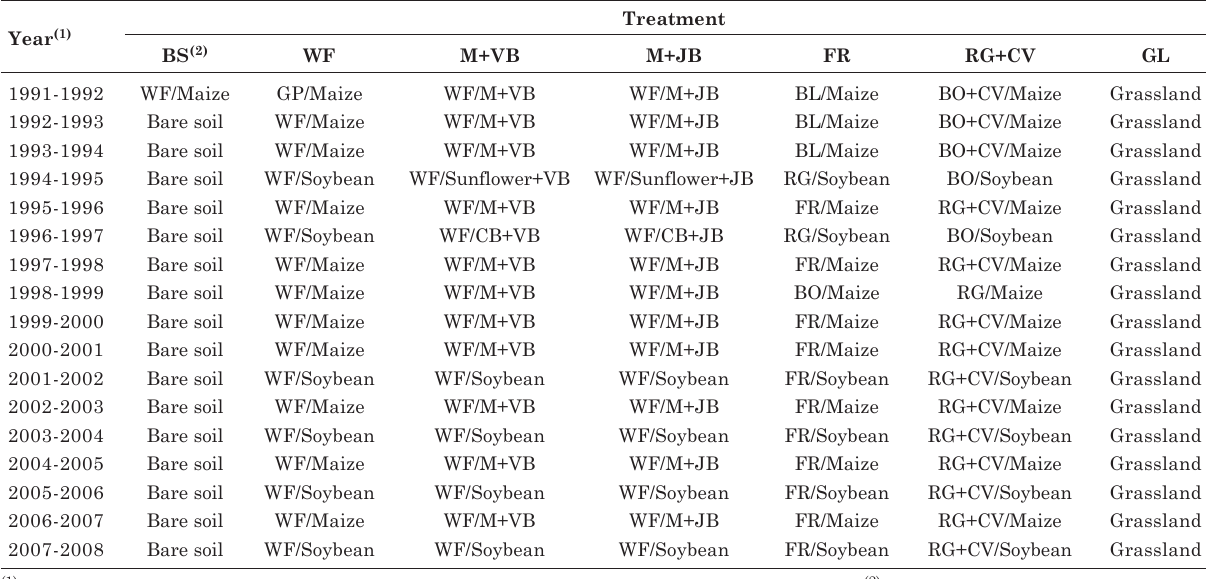
(1) Corresponding to the period from April of the first year to March of the following year. (2) BS: Bare soil; WF: Winter fallow; Maize: Zea mays L.; GP: Grass Pea ( Lathyrus sativus L.) Soybean: Glycine max (L.) Merrill; M+VB: Intercrop maize - velvet bean ( Stizolobium cinereum Piper & Tracy); Sunflower+VB: Intercrop of Sunflower ( Helianthus annuus L.) and Velvet Bean; CB+VB: Intercrop of Commom Bean ( Phaseolus vulgaris L.) and Velvet Bean; M+JB Intercrop of Maize and Jack Bean ( Canavalia ensiformis (L.) DC.); Sunflower+JB: Intercrop of Sunflower and Jack Bean; CB+JB: Intercrop of Commom Bean and Jack Bean; FR: Forage Radish ( Raphanus sativus L.); BL: Blue Lupine ( Lupinus angustifolius L.); RG: Ryegrass (